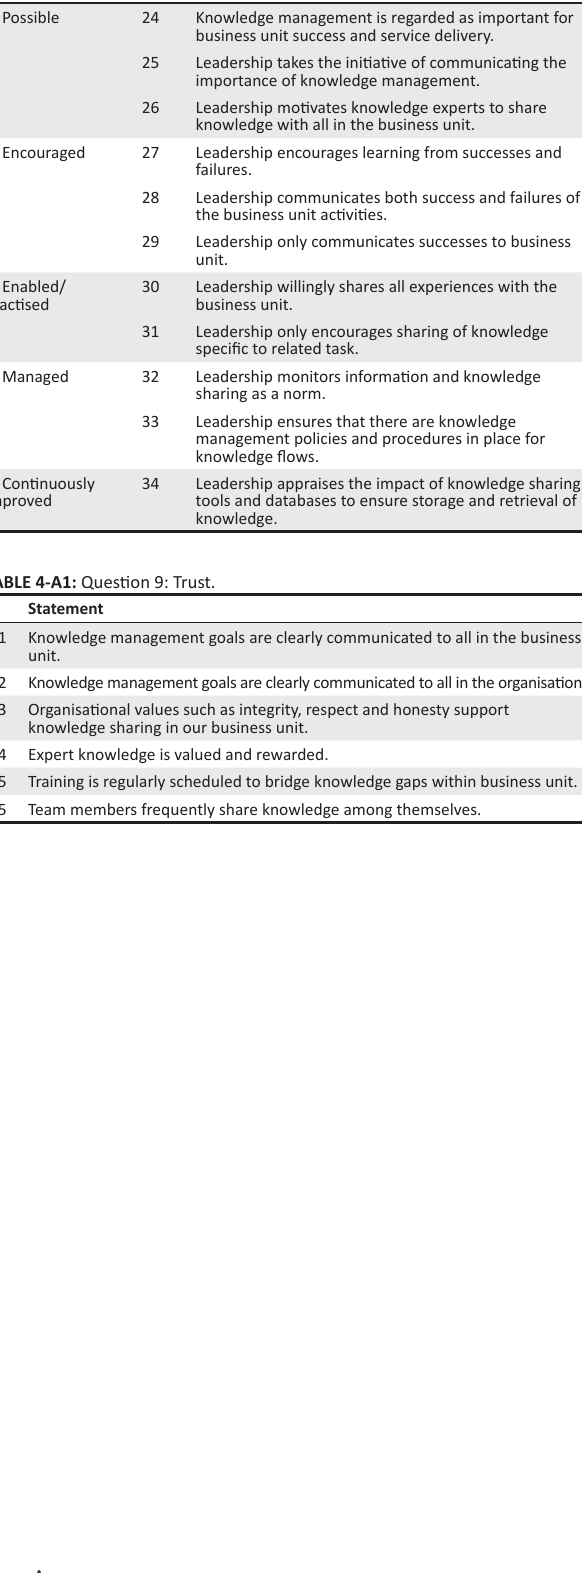
TABLE 1-A1: Question 6: Value of knowledge. Capability